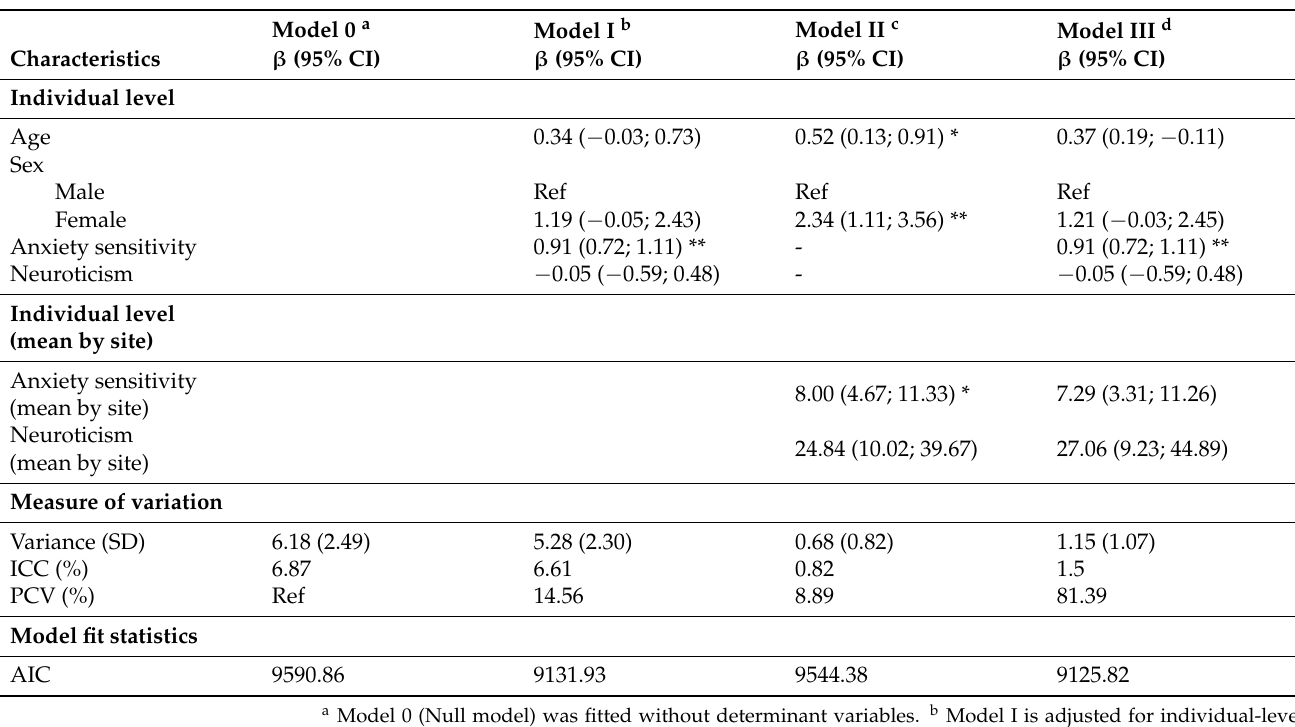
Table 4. Factors associated with COVID-19-Specific Distress.